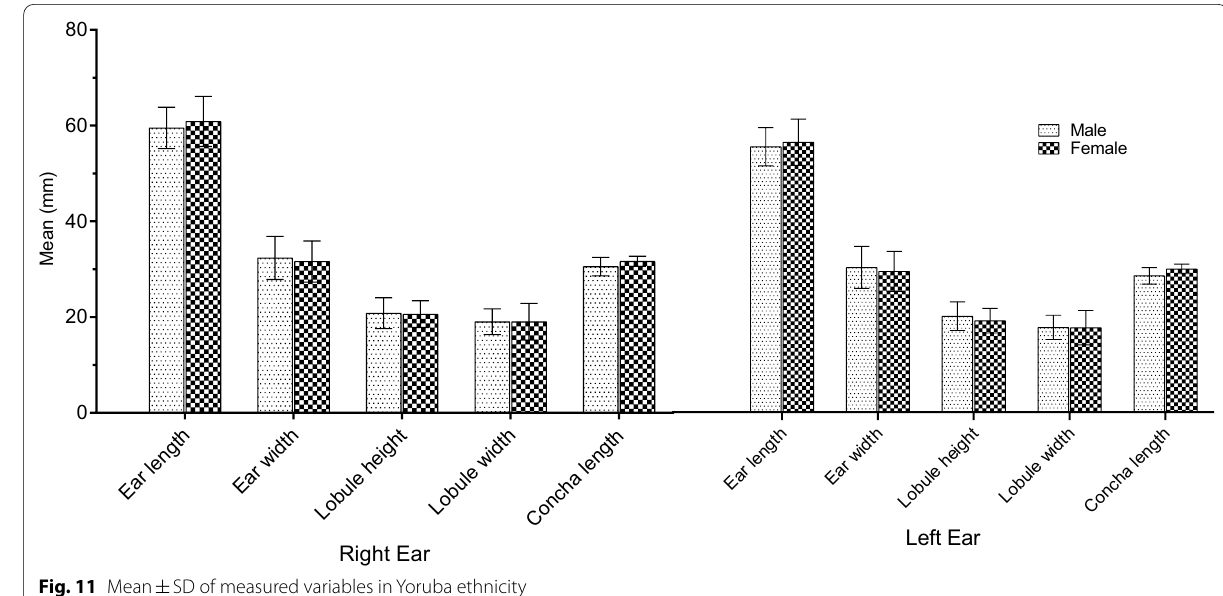
Fig. 11 Mean SD of measured variables in Yoruba ethnicity ±